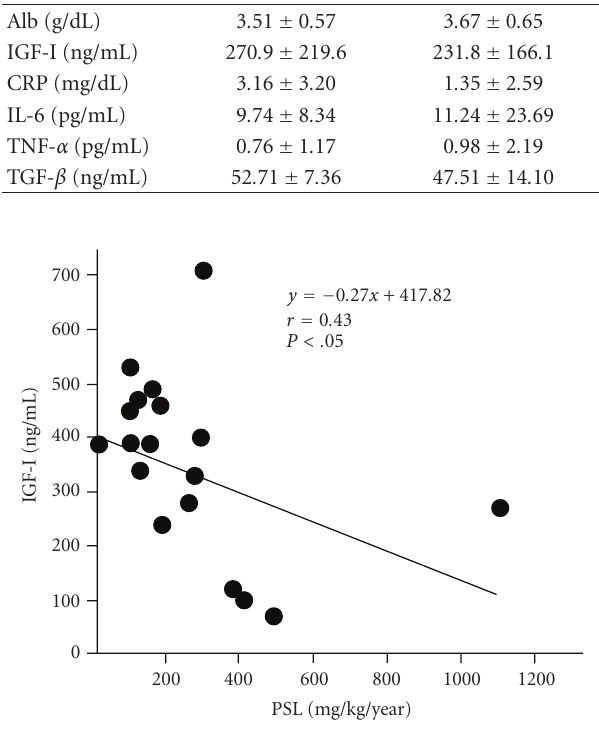
Figure 5: Correlation between serum IGF-I level and the amount of PSL administered in children with IBD in the 1-year period following the start of